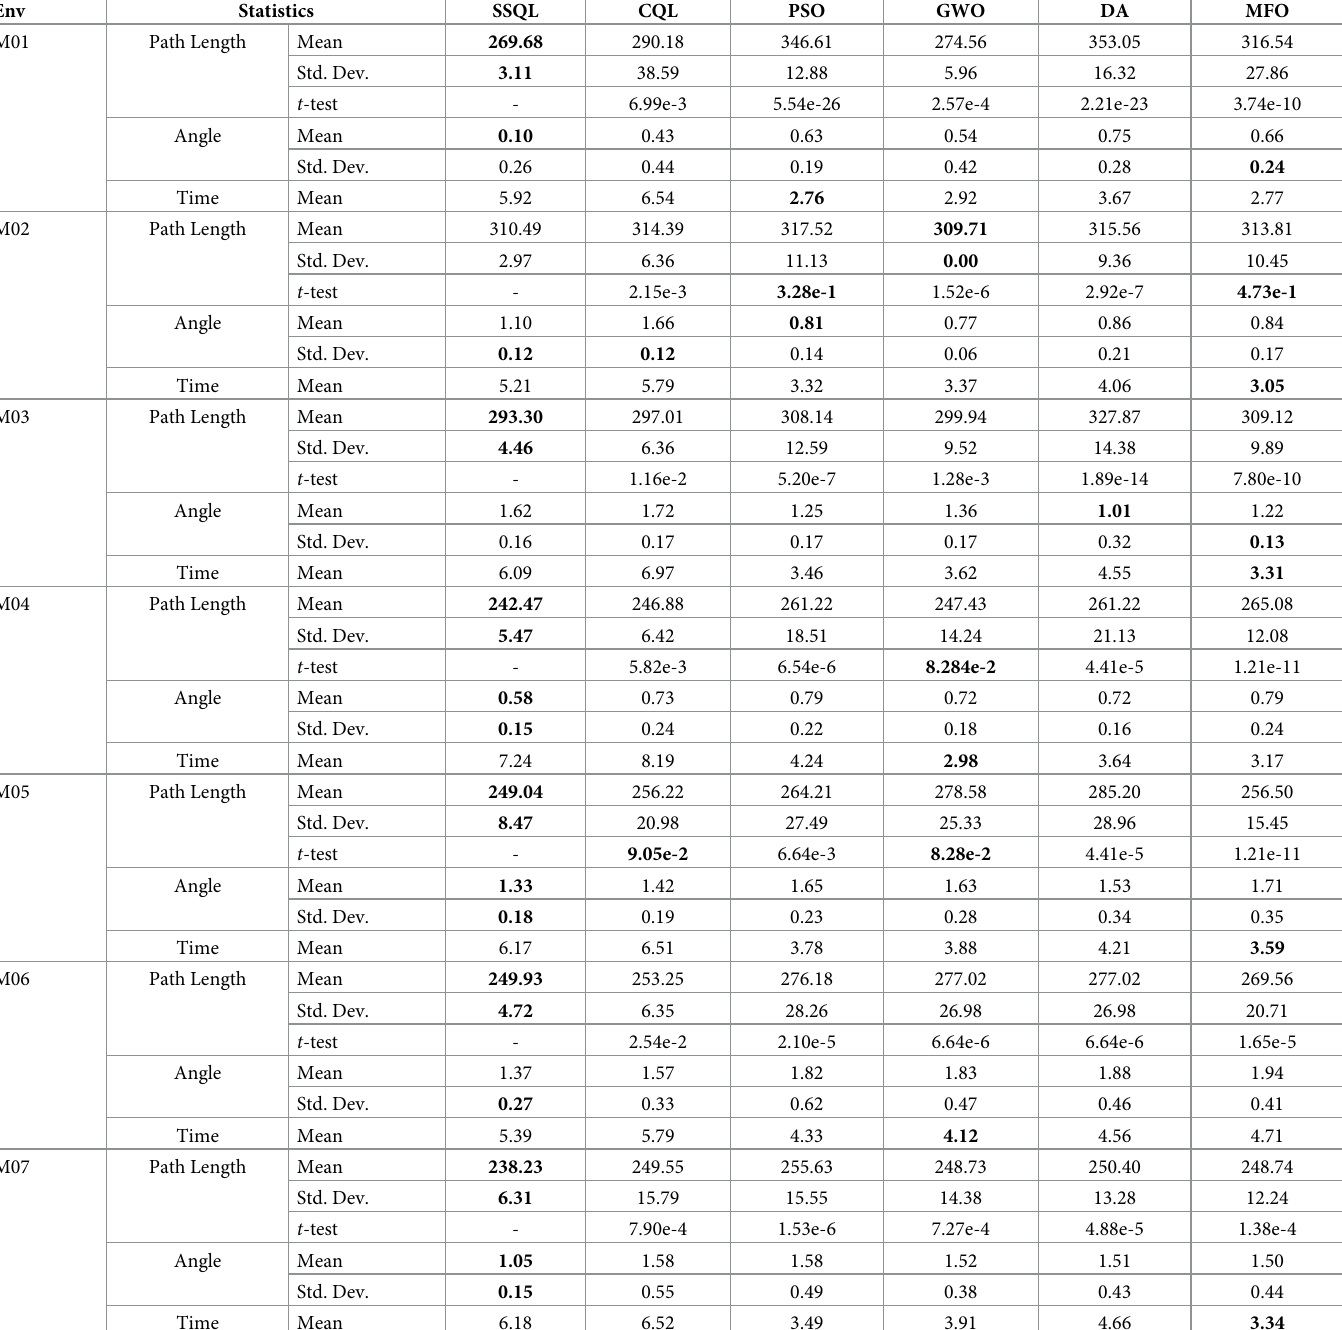
Table 2. A comparison between SSQL, CQL, PSO, GWO, DA and MFO for short path planning. The lowest (best) both mean, standard deviation, and the values of path length bigger than the level 0.05 of significance are highlighted. Env M01 Path Length